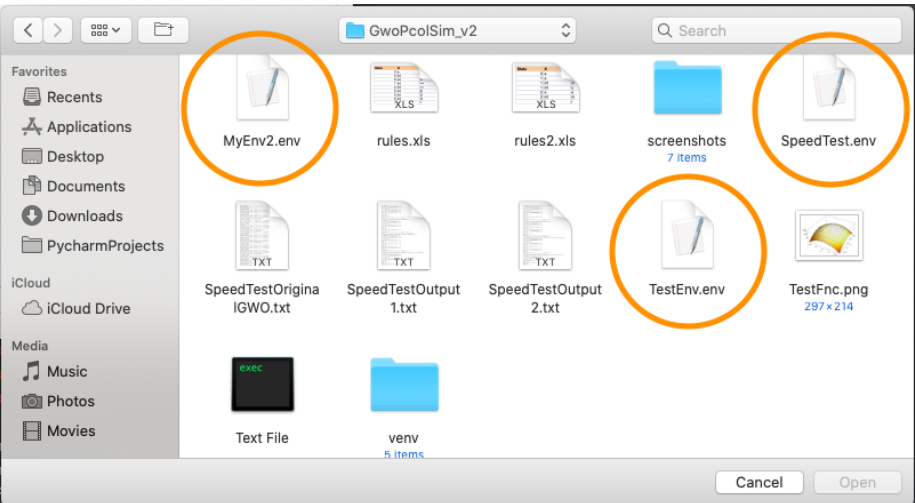
Figure 8. An example of the file dialog window (environment files are